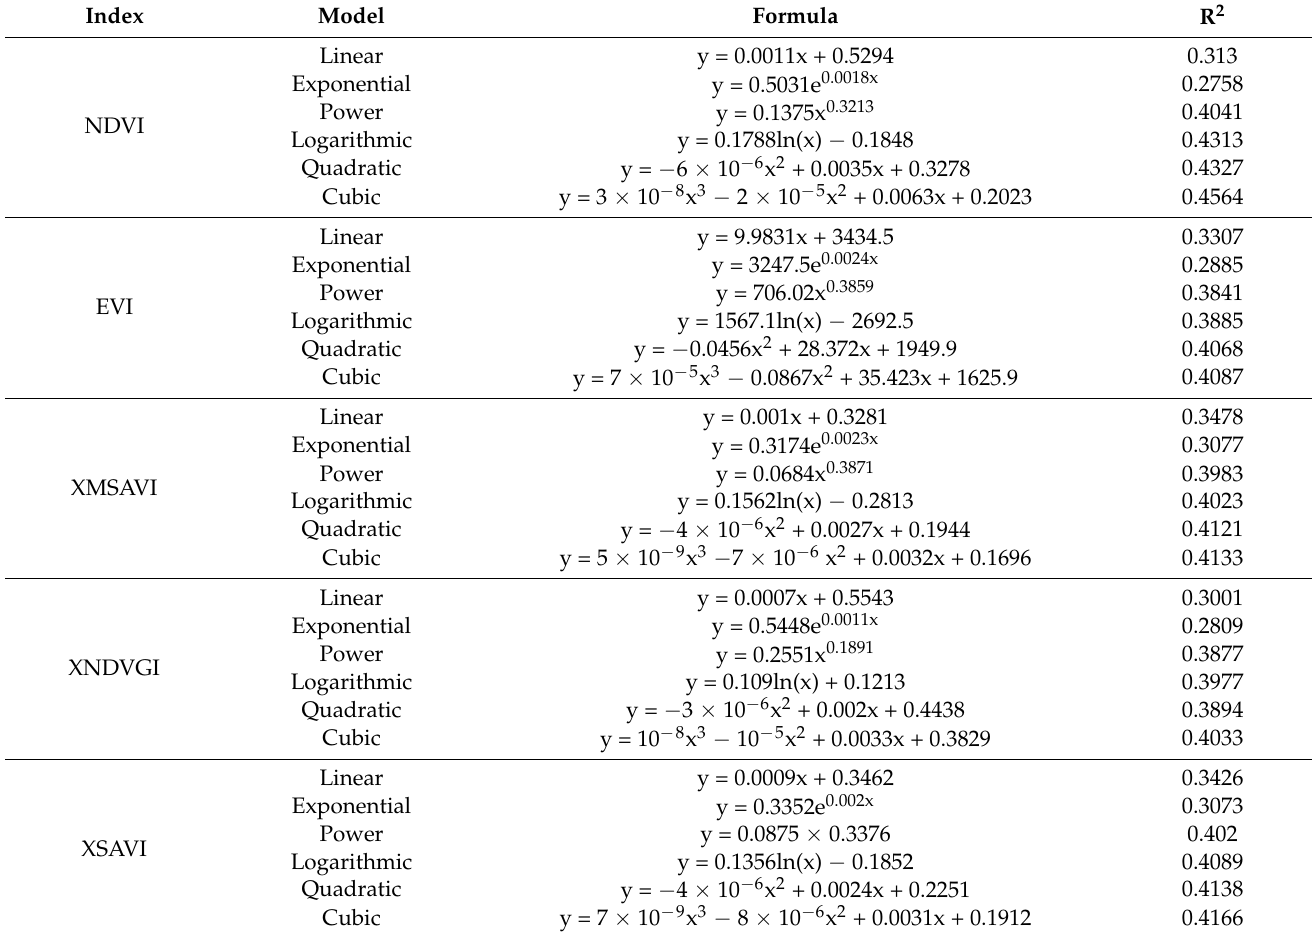
Table 5. Fitting results of vegetation index and